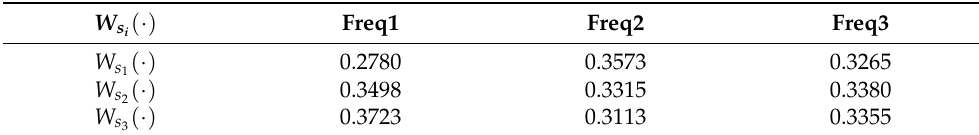
Table 9. Weight of